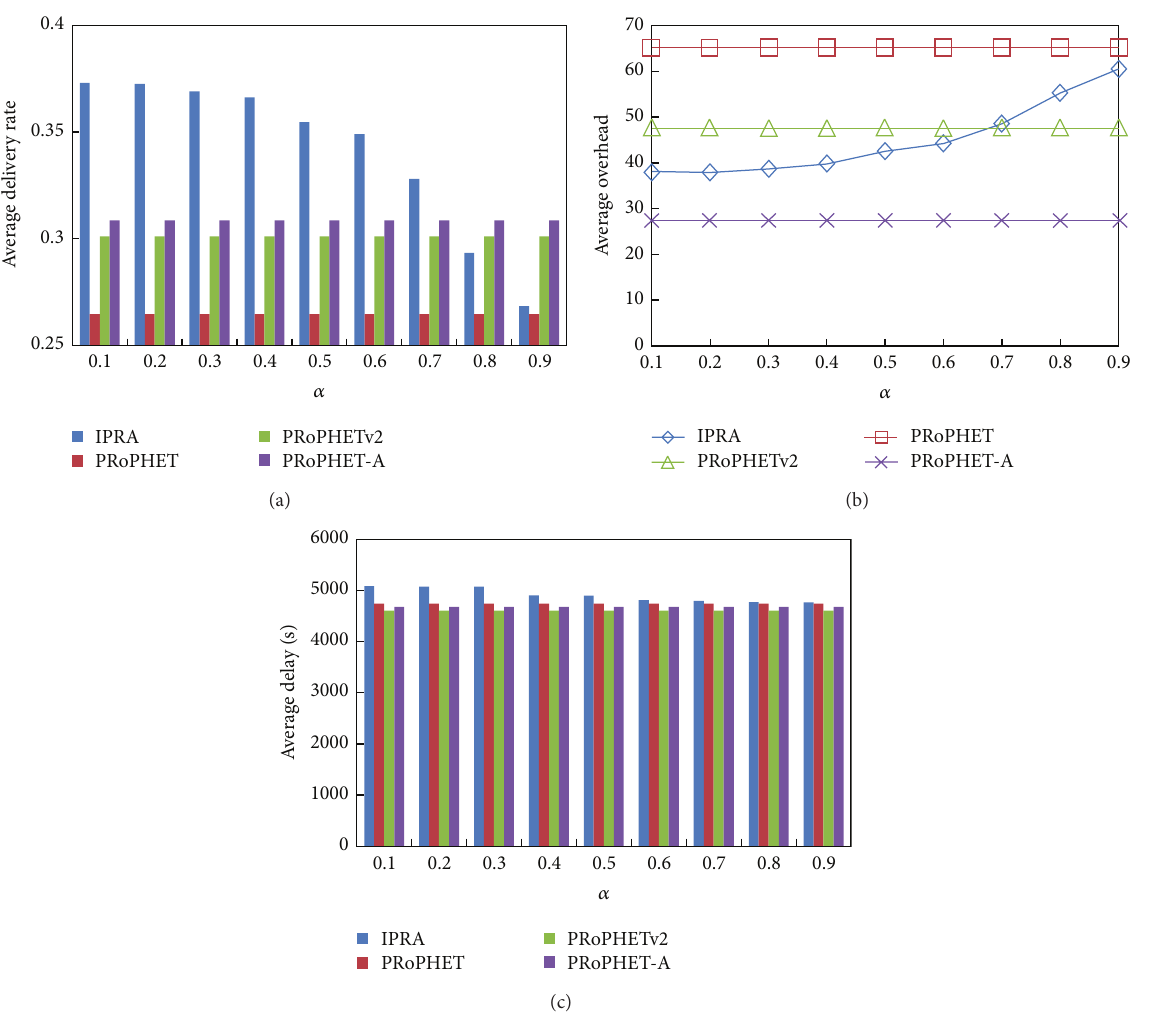
Figure 3: The performance of IPRA with different values of 𝛼 : (a) average delivery rate (ADR); (b) average overhead (AO); (c) average delay